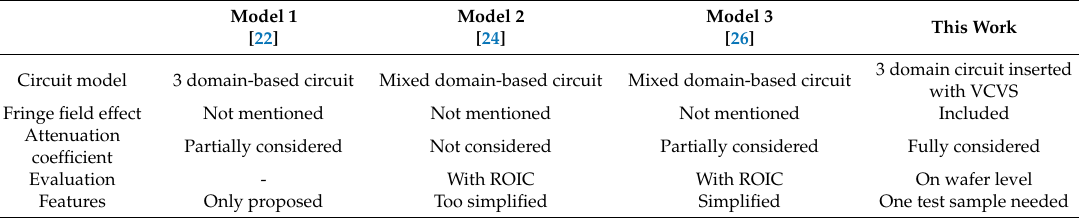
Figure 8. ( a ) Modelled dynamic open-circuit sensitivities based on bias voltages (7.5 V, 9.0 V, 10.0 V) of a capacitive MEMS acoustic sensor; ( b ) modelled dynamic open circuit sensitivities according to parasitic capacitances (0.43 pF, 0.80 pF, 1.20 pF) at 10.0 V bias condition of a capacitive MEMS acoustic sensor. Table 1. Comparisons between the proposed study and the currently published